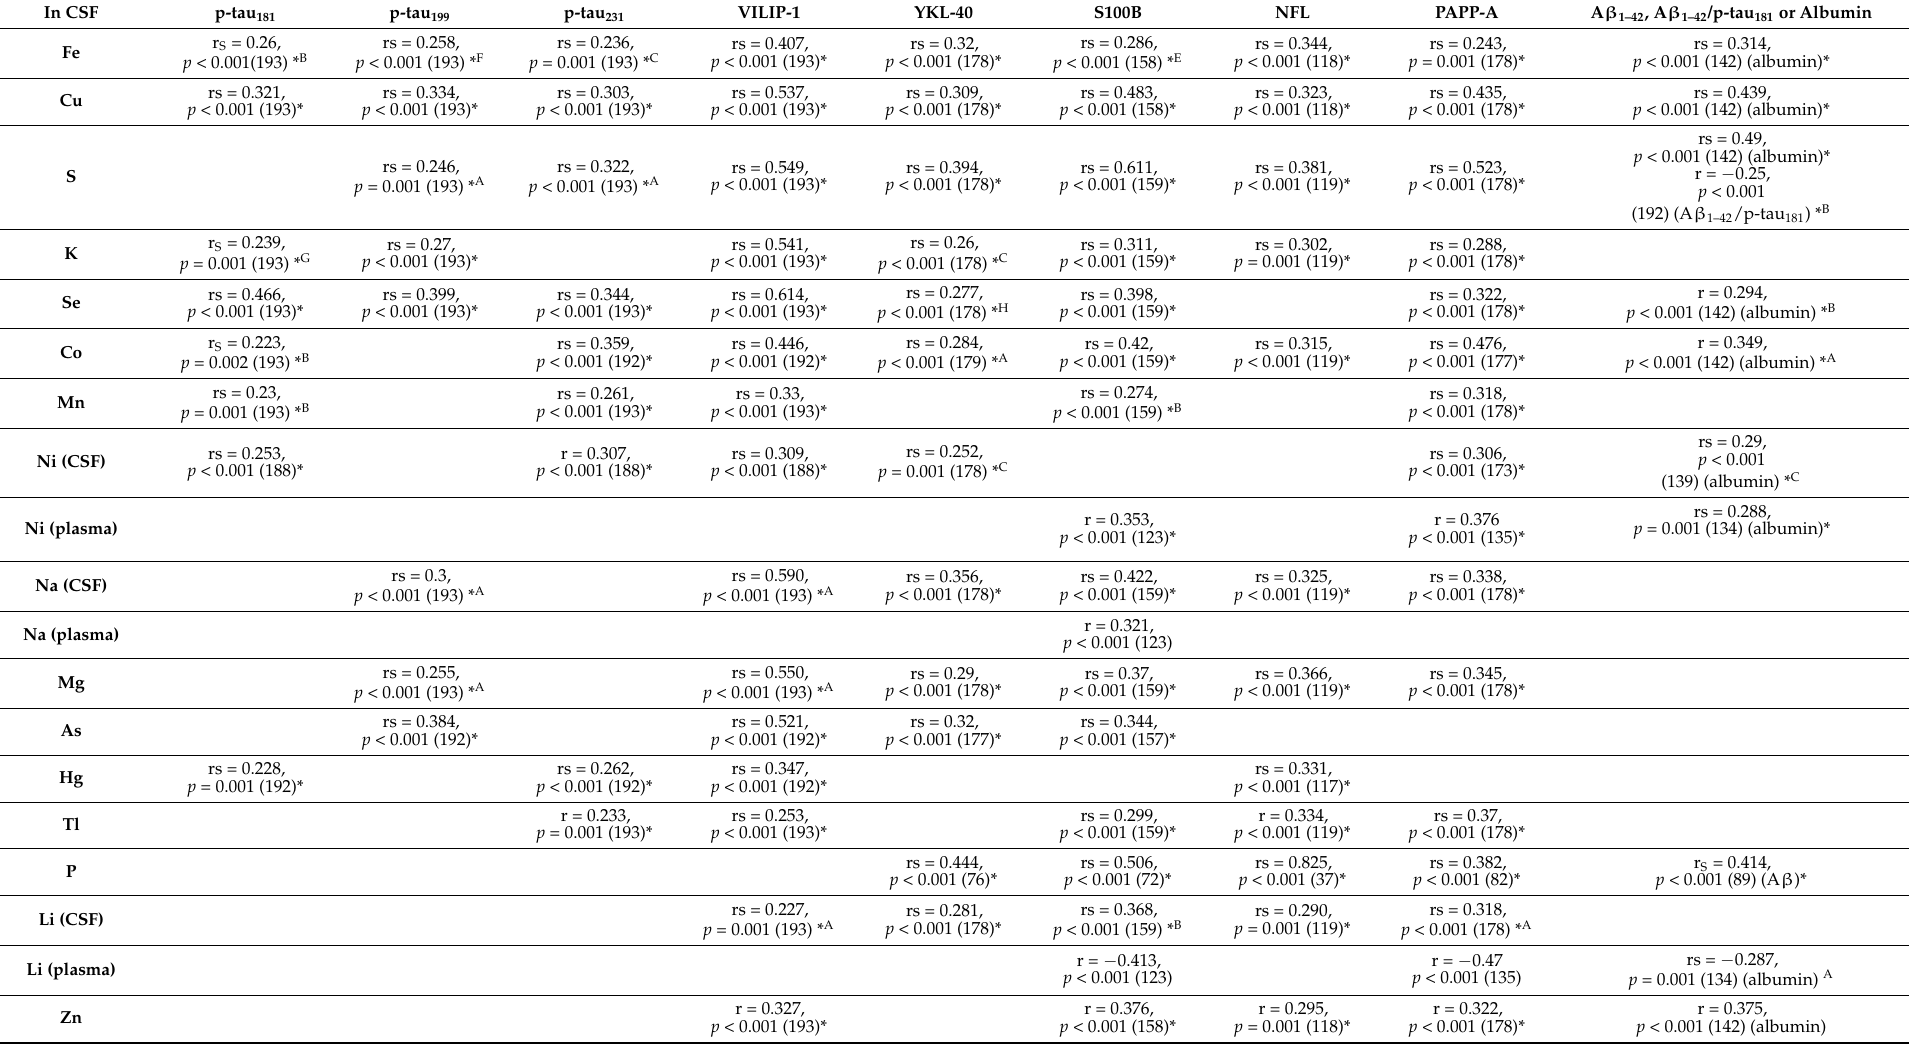
Table 1. Correlations of CSF AD biomarkers with macro- and